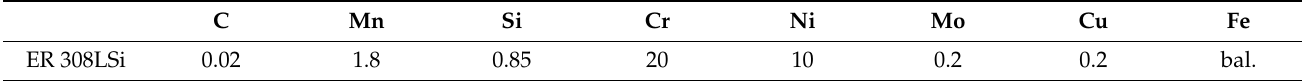
Table 5. Chemical composition of insert element, wt. %.